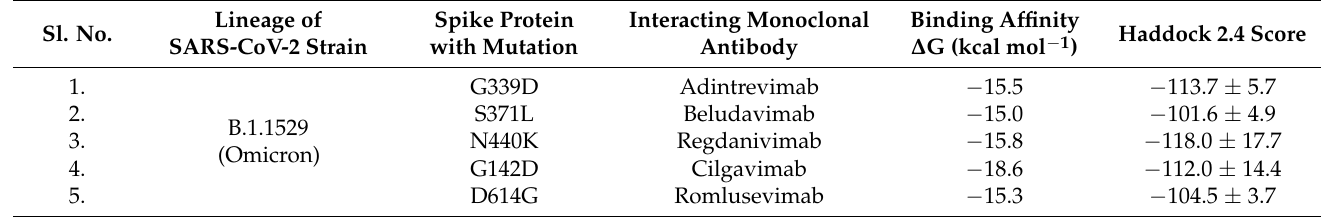
Table 1. Selected mAbs and their level of binding efficacy against mutant spikes of B.1.1529 (Omicron)